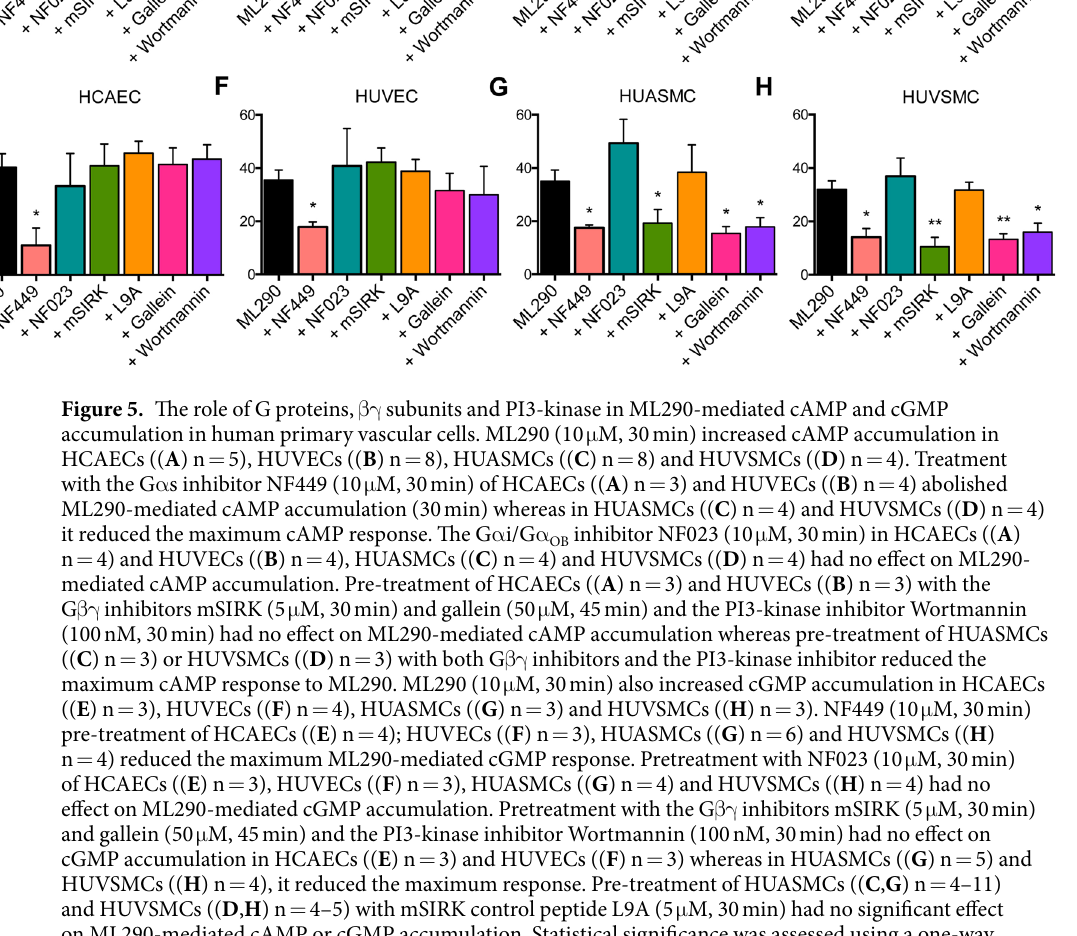
gallein (50 μ M, Fig. 5A,B) or Wortmannin (100 nM, 30 min, Fig. 5A,B), suggesting that ML290-mediated cAMP signalling in these cells was predominantly regulated by G α s . In contrast, in smooth muscle cells, NF449 (10 μ M, 30 min) only partially but significantly inhibited ML290-mediated cAMP accumulation in HUASMCs (Figs 5C and S3C) from 18.8 ± 4.3% to 6.0 ± 7.3% (p < 0.05) and in HUVSMCs (Figs 5D and S3D) from 18.8 ± 8.0% to 4.7 ± 2.5% (p < 0.05). Unlike endothelial cells, in smooth muscle cells, mSIRK (5 μ M, 30 min, Figs 5C,D and S3C,D) reduced ML290-mediated cAMP